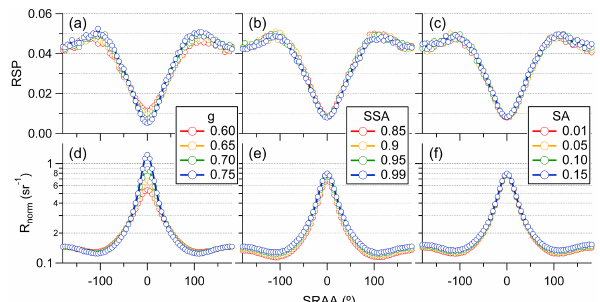
Figure 5. Sensitivity study showing simulated RSP (top row) and sun-normalized radiances, R norm (sr − 1 ) , defined as the ratio of the radiance (Wm 2 sr − 1 ) in the geometry indicated to the solar irradi- ance (Wm 2 ) (bottom row) at 430nm for several input parameters: (a, b) g , (c, d) SSA, and (e, f) SA. The simulations were carried out assuming a box extinction profile (1.5km height) with an AOD of 0.2 and SZA = 70 ◦